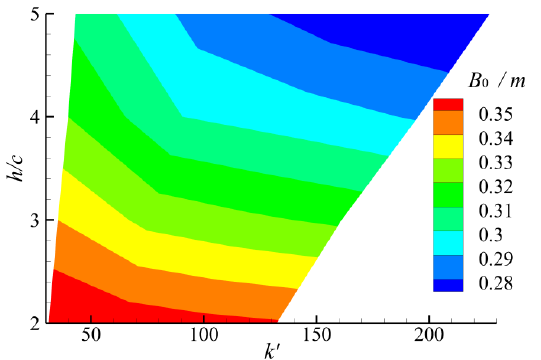
Figure 22. Distribution diagram of ship bow heaving amplitude under different span and spring stiffness.